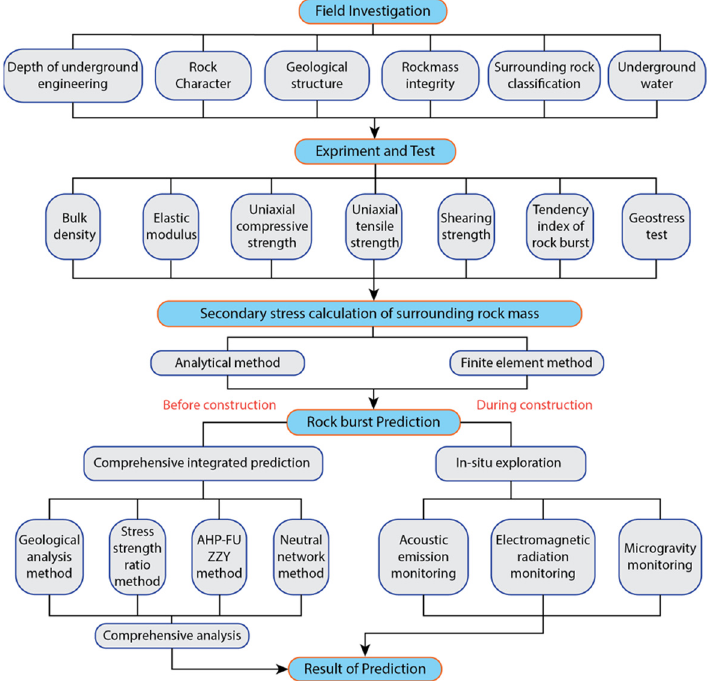
Figure 10. Academic and scientific approaches of comprehensive rockburst prediction (modified after ref. [145]).